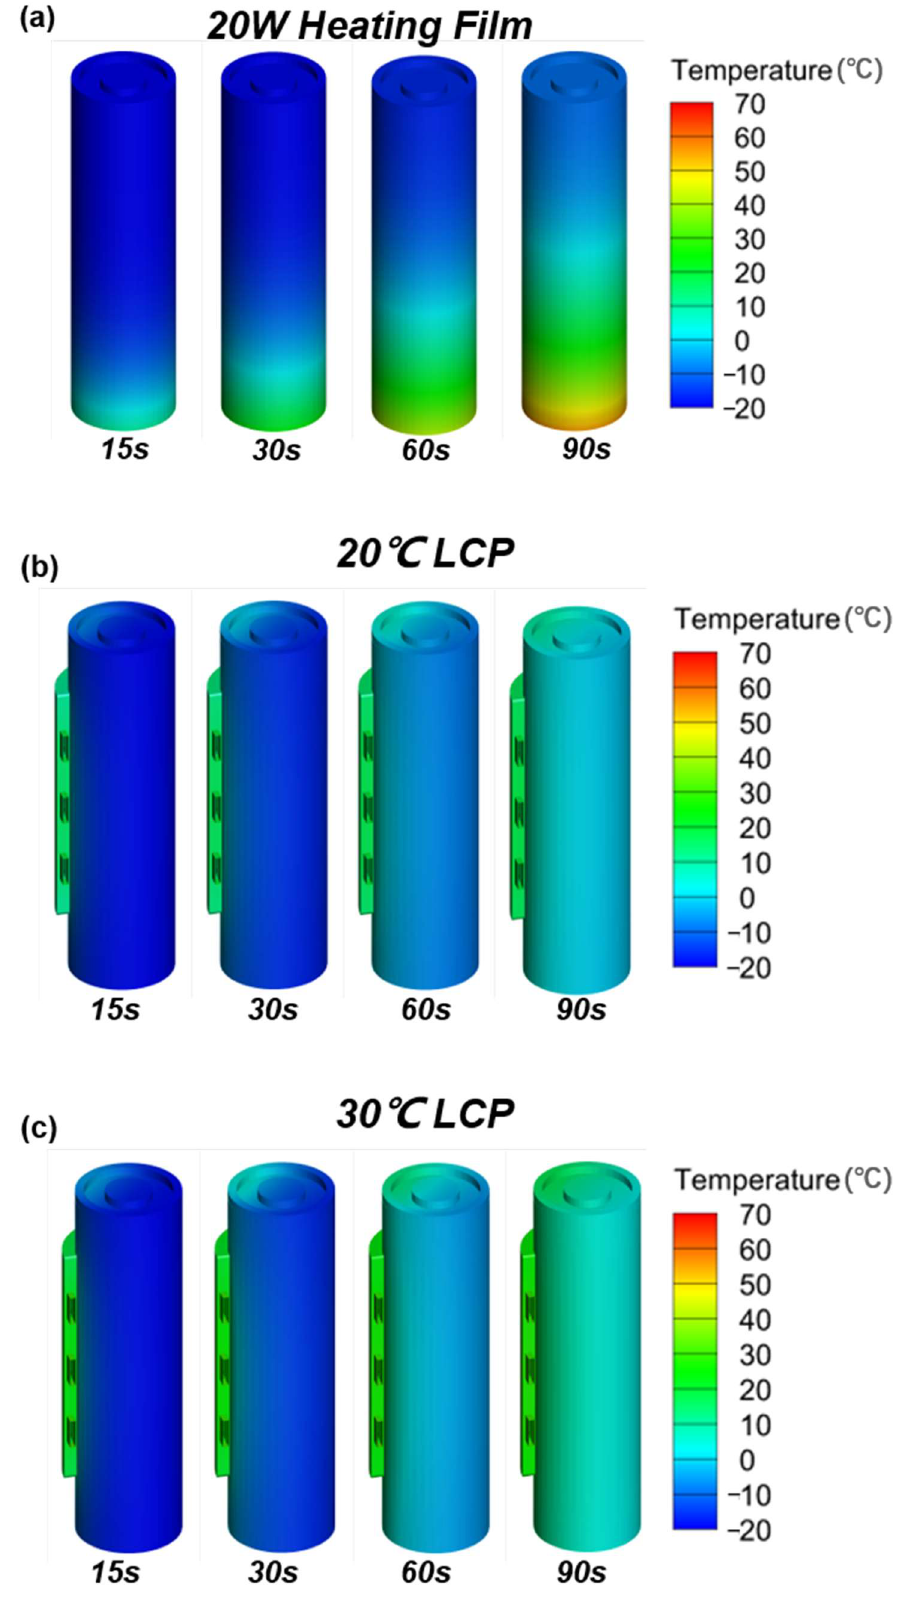
Figure 8. Temperature distribution of the cell surface with different heating methods. ( a ) 20 W HF; ( b ) 20 °C LCP; ( c ) 30 °C LCP.